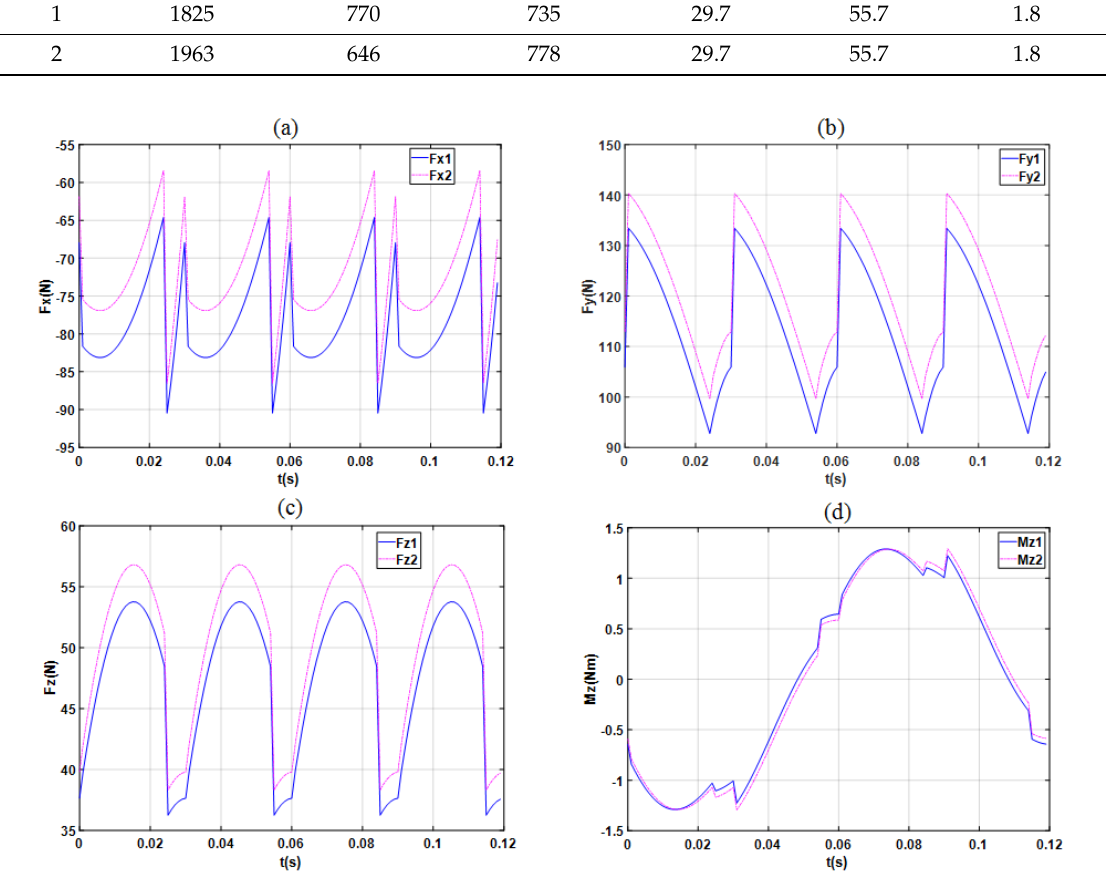
Figure 10. The cutting forces corresponding to the two cases of calculation and cutting force coefficient selection. (a)F x -(N);(b)-F y (N); (c)F z -(N);(d)-M z (Nm). selection. ( a )F x -(N);( b )-F y (N); ( c )F z -(N);( d )-M z